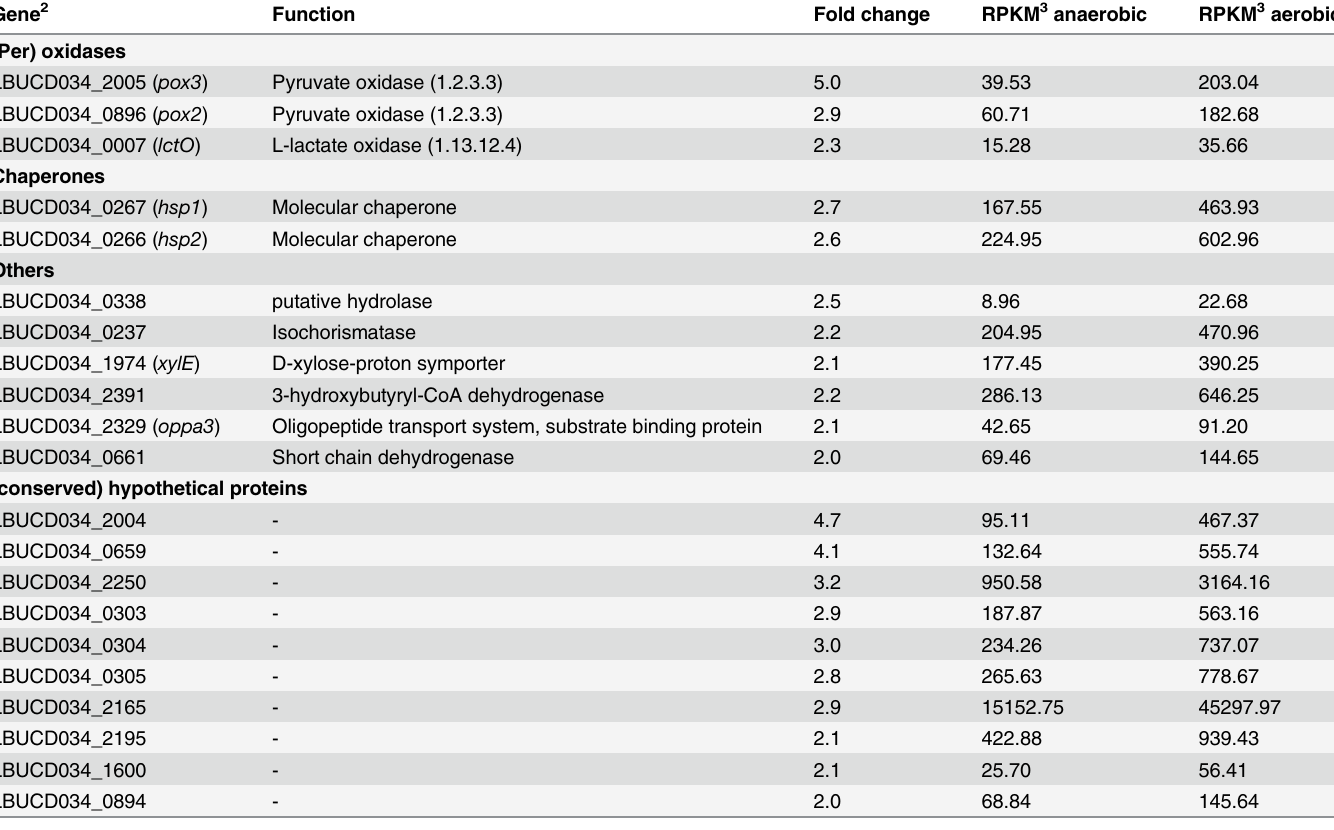
Table 3. Genes of L . buchneri CD034 found to be highly 1 up-regulated under aerobic vs . anaerobic conditions. Gene 2